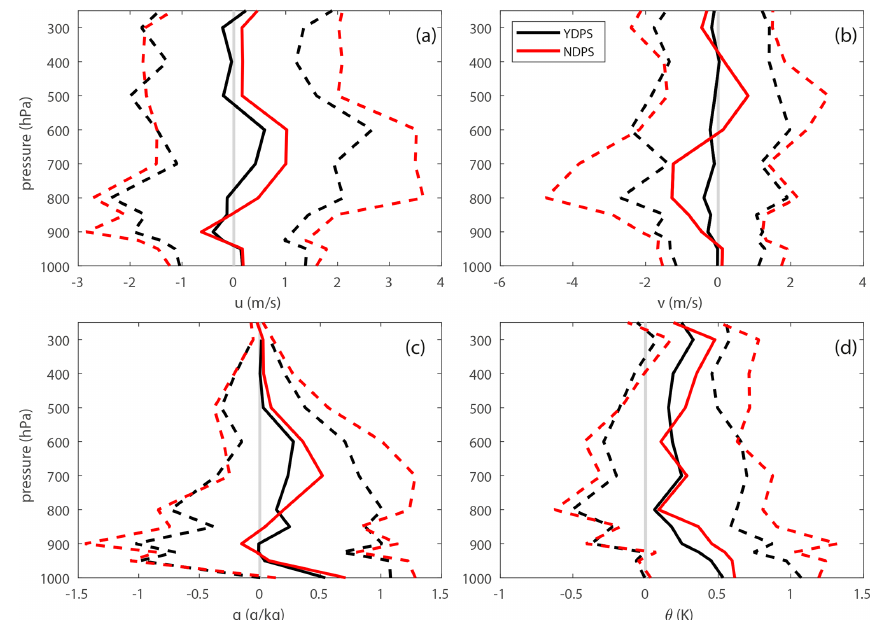
Figure 5. The mean (solid line) and 1 standard deviation (dashed line) of departures from the observations, for (a) zonal wind, (b) meridional wind, (c) the water vapor mixing ratio, and (d) potential temperature, for the control run in black and the dropsonde denial experiment in red.